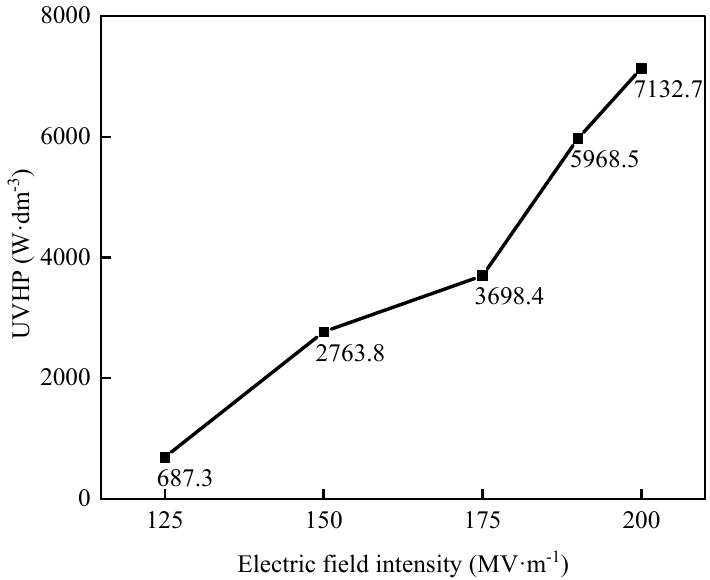
Electric field intensity (MV·m -1 ) Figure 18. UVHP at different electric field Figure 18. UVHP at di ff erent electric fi eld intensities.